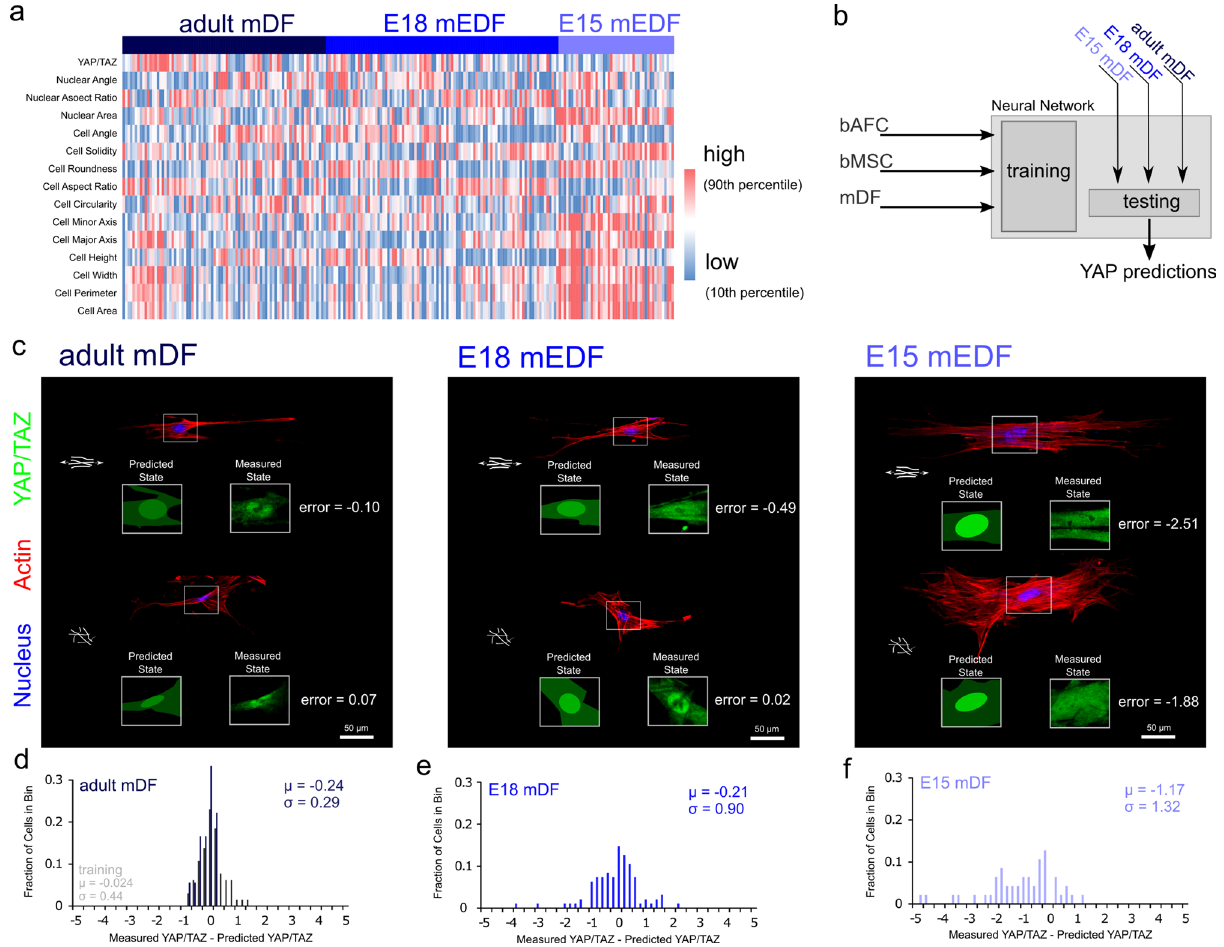
Figure 4. Developing murine dermal fibroblasts have emergent morphology-mechanosensing relationships. Murine dermal fibroblasts from adults and embryonic days 15 and 18 were isolated and seeded onto organized and disorganized fiber environments. ( a ) Staining for actin, the nucleus, and YAP/TAZ revealed heterogeneity and developmental stage specific morphology and mechanosensing. ( b ) The neural network described above (Fig. 3) was updated and retrained based on AFCs, MSCs, and adult murine dermal fibroblasts (mDFs) and tested on the remaining dermal fibroblast groups ( c ). In general, YAP/TAZ levels were predictable for ( d ) adult and ( e ) E18 cells (µ adult = − 0.24, σ adult = 0.29; µ e18 = − 0.21, σ e18 = 0.90). (f) However, YAP/TAZ levels were largely overestimated for dermal fibroblasts isolated from the mid-gestational fetus (E15), which is a stage associated with scarless healing (µ e15 = − 1.17, σ e15 = 1.32), (n DF-train = 65, n DF-test = 18, n E18 = 95, and n E15 = 47